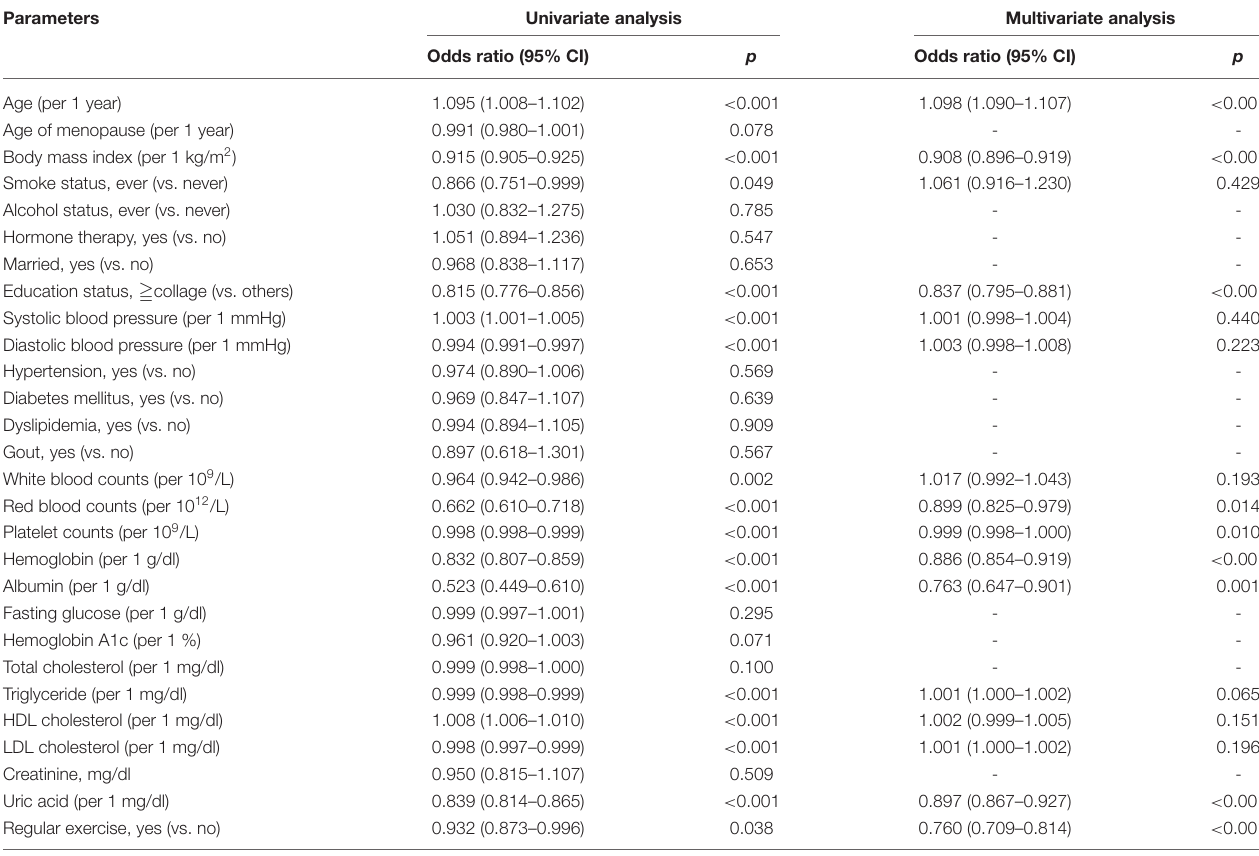
TABLE 2 | Odds of osteoporosis at baseline in the cross-sectional cohort ( N = 30,046). Parameters